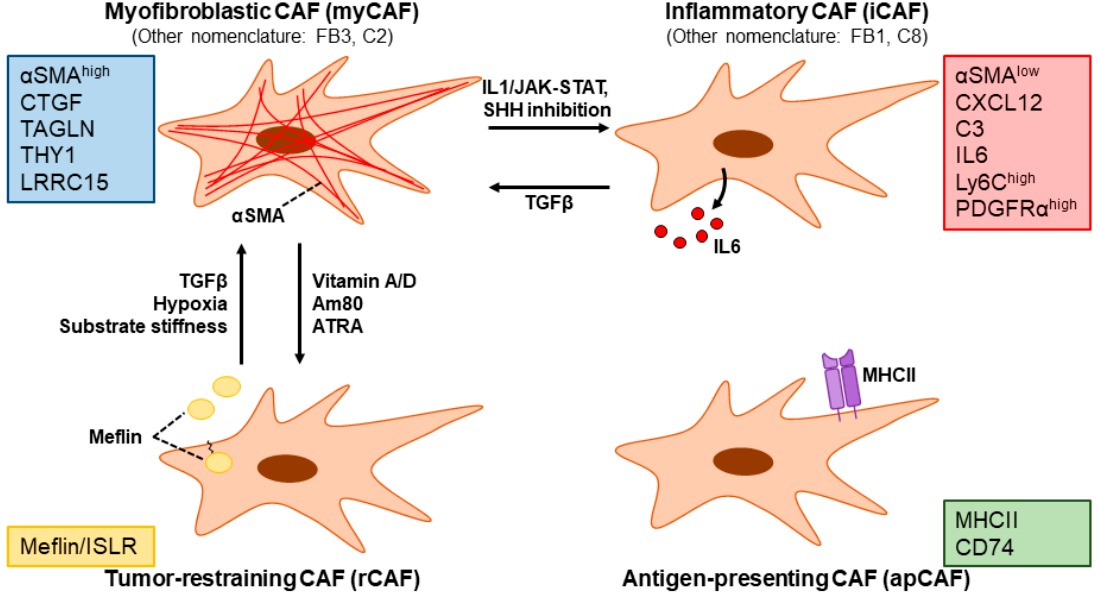
Figure 6. CAF subpopulations in PDAC and representative molecular markers. Myofibroblastic CAFs (myCAFs, also referred to as the FB3 or C2 subpopulation) are characterized by the high expression of α SMA. Inflammatory CAFs (iCAFs, also referred to as FB1 or C8 subpopulation) are characterized by the low expression of α SMA as well as the expression of inflammatory cytokines such as interleukin (IL) 6. rCAFs are characterized by the expression of Meflin/ISLR. Antigen-presenting CAFs (apCAFs) express MHC class II and CD74. TGF β signaling as well as hypoxia and substrate stiffness has been shown to induce a myCAF phenotype. IL1 signaling through JAK-STAT as well as sonic hedgehog (SHH) signaling inhibition induces a myCAF-to-iCAF conversion. Vitamin A/D, the synthetic retinoid Am80, and all- trans retinoic acid (ATRA) promote the induction of the rCAF subpopulation. Note that the figure illustrates some of the more well-characterized CAF subpopulations to date and is not meant to be an exhaustive